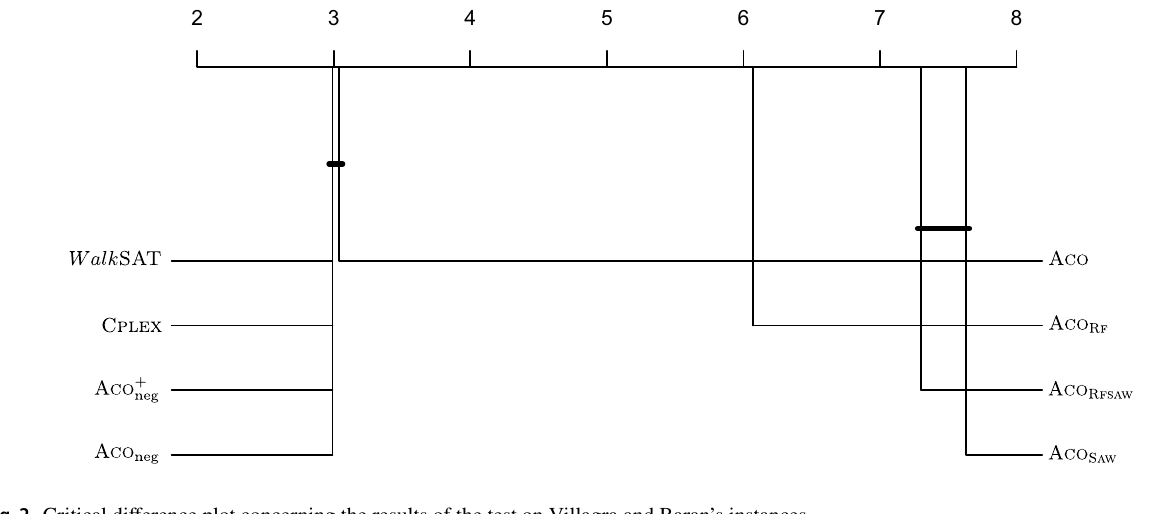
Fig. 2 Critical difference plot concerning the results of the test on Villagra and Baran’s instances